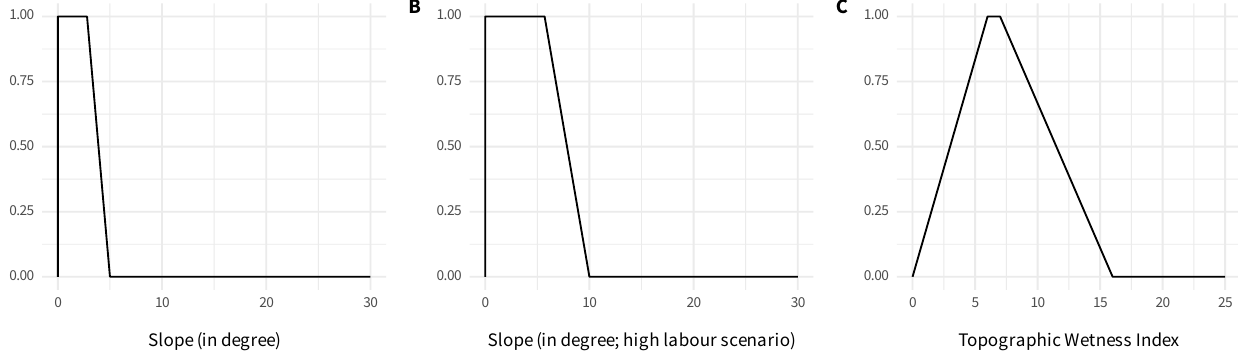
Figure 2. Fuzzy membership function to translate input raster to fuzzy sets. ( A ) suitable slope for agricultural production; ( B ) suitable slope for agricultural production under conditions of intensive labour input; ( C ) suitable moisture conditions for agricultural practices, i.e., not too moist and not too dry.